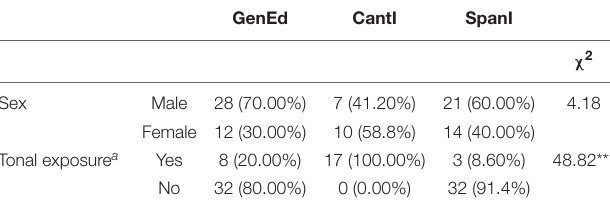
TABLE 1B | Frequency (percentage of total) of sample characteristics and tests of expected frequencies at Time